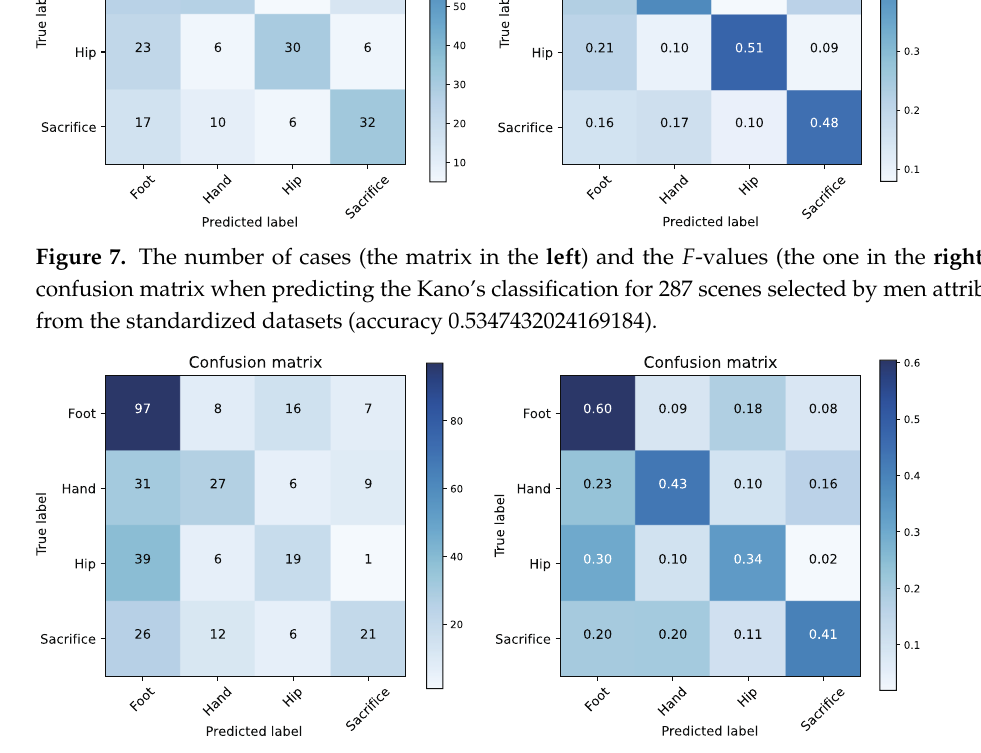
Figure 8. The number of cases (the matrix in the left ) and the F -values (the one in the right ) in confusion matrix when predicting the Kano’s classification for 287 scenes selected by women attribute from the standardized datasets (accuracy